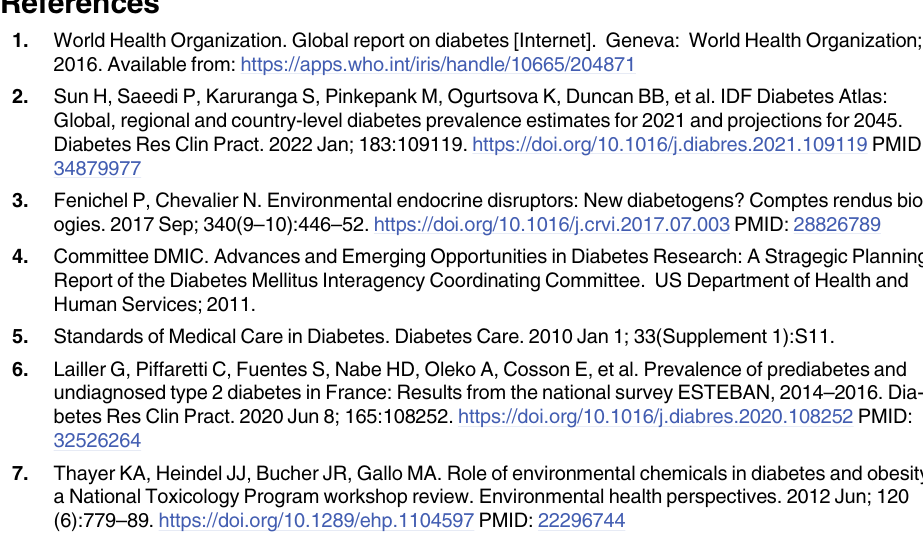
S1 Table. Characteristics of the two populations. Results are presented as mean ( ± standard error) for continuous variables and as number (percentage) for categorical